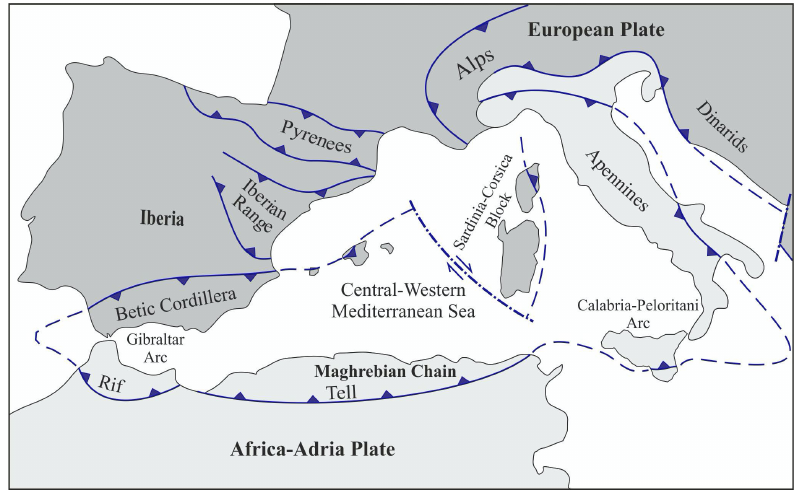
Figure 1. Simplified tectonic map of the central-western peri-Mediterranean chains (after [2],